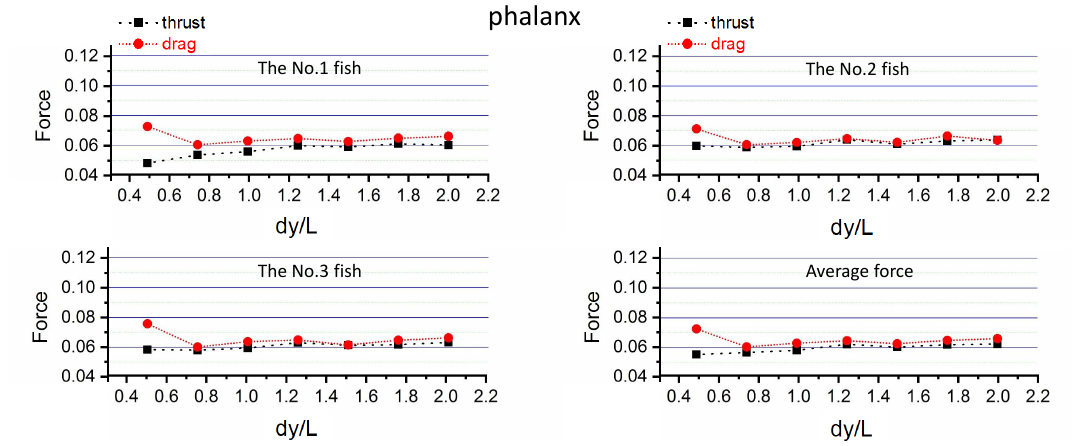
Figure 12. The thrust and drag at different spacing of the phalanx